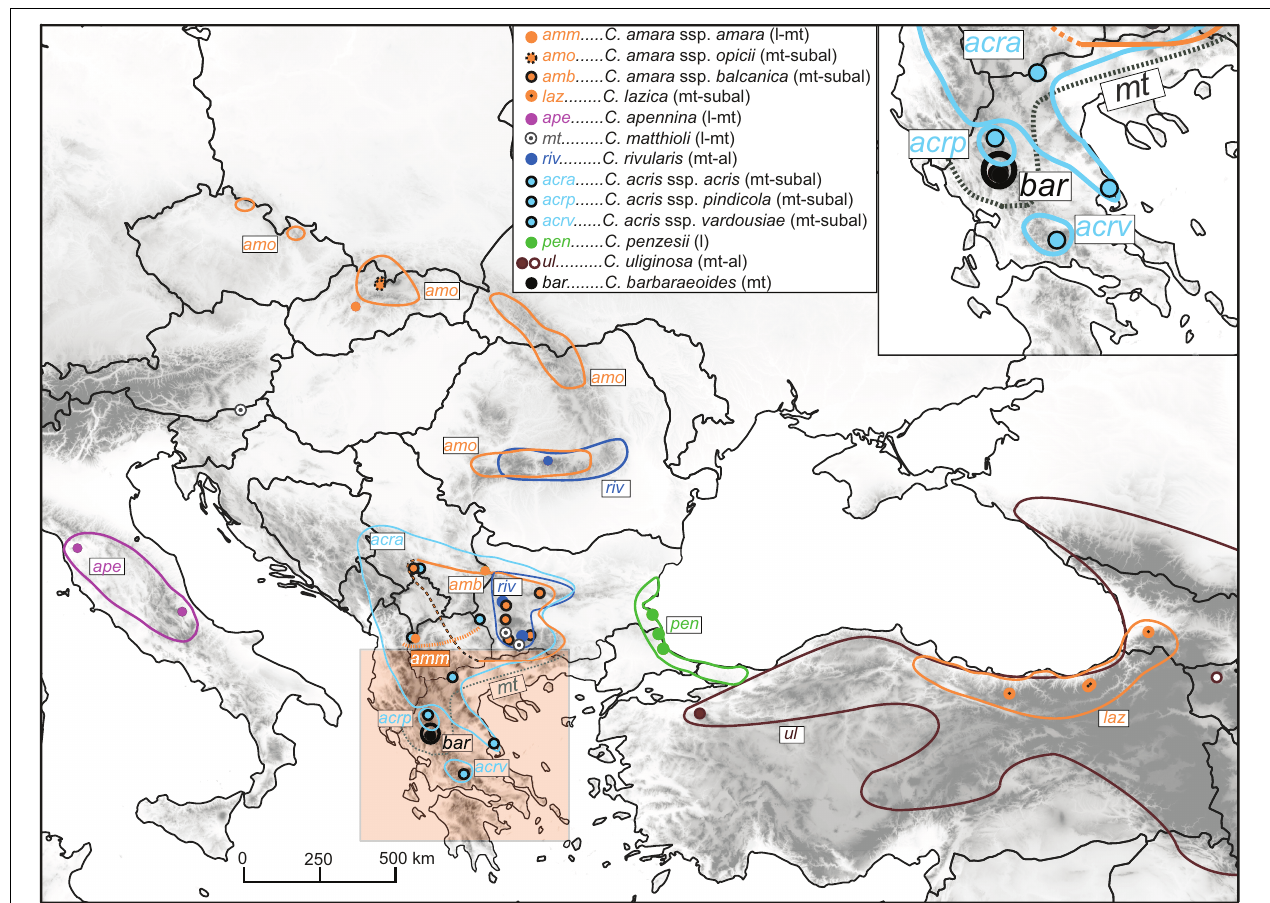
FIGURE 1 | Distribution of the Cardamine taxa under study, based on data compiled from floras, herbarium specimens, previous studies, and our own records. The western borders of the area of Cardamine amara subsp. balcanica remain unknown (marked here by a black–orange dashed line; see Tomovi´c et al., 2009); this taxon has been thoroughly studied so far only in its Bulgarian range (Marhold et al., 1996). Cardamine matthioli and C. amara subsp. amara are widespread taxa in Europe (Jalas and Suominen, 1994), but their precise distribution in the Balkan Peninsula remains unclear, with the southernmost records reported from central and northeastern Greece (gray dotted line; Marhold and Tan, 2000) and North Macedonia (orange dotted line; Jalas and Suominen, 1994; Tomovi´c et al., 2009, and this study), respectively. The area of Cardamine uliginosa extends further to the south and southeast, reaching the mountains of Iran and Lebanon. The occurrence of the taxa along the elevational gradient is indicated in brackets as follows: l, lowland; mt, montane; subal, subalpine; al, alpine belt. Circles indicate our sample sites; see Supplementary Data Sheet 1 for details on the populations sampled.